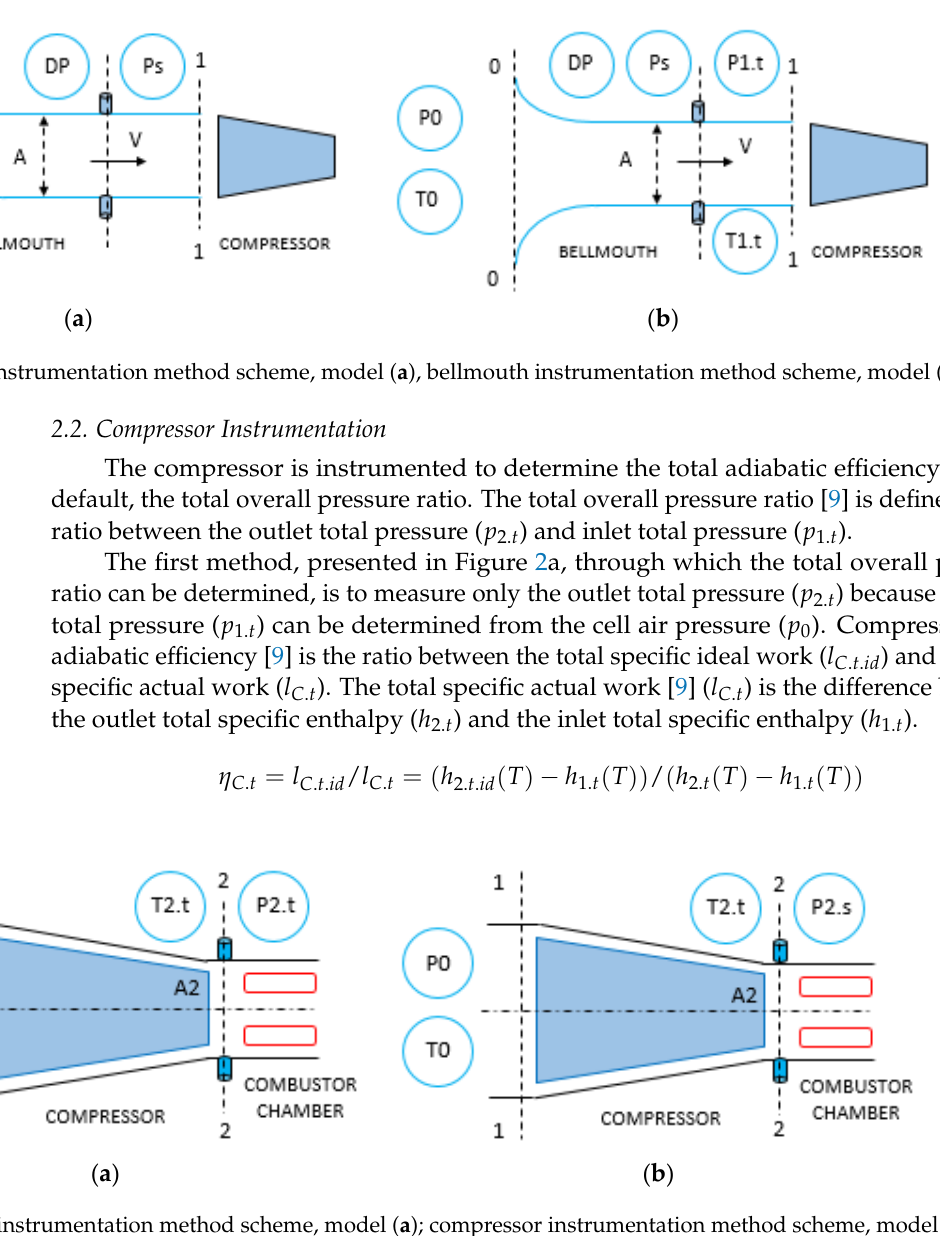
Figure 1. Bellmouth instrumentation method scheme, model ( a ), bellmouth instrumentation method scheme, model ( b ).